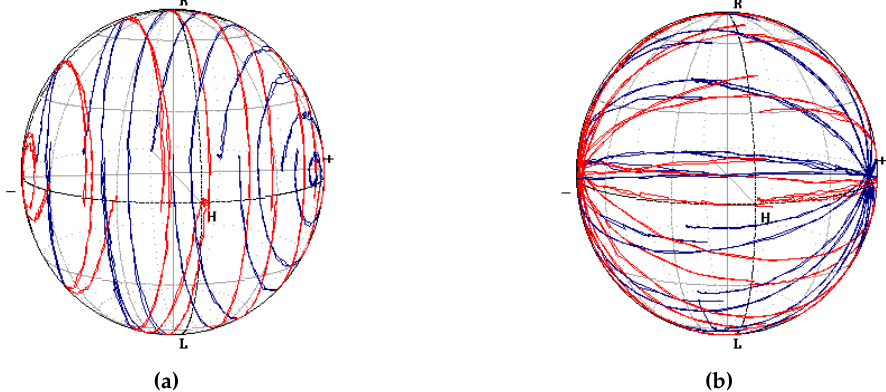
Figure 22. Curves traced on the polarimeter when scanning on ( a ) φ 1 and ( b ) φ 2 , while keeping the other phase constant. The polarimeter has been calibrated so that the SOP from the SPGC is shown as a 45 ◦ linear polarisation. Red curves lie on the hemisphere on the observer’s side, blue ones on the rear one. The axes are rotated by 90 ◦ around s 3 , with respect to Figure